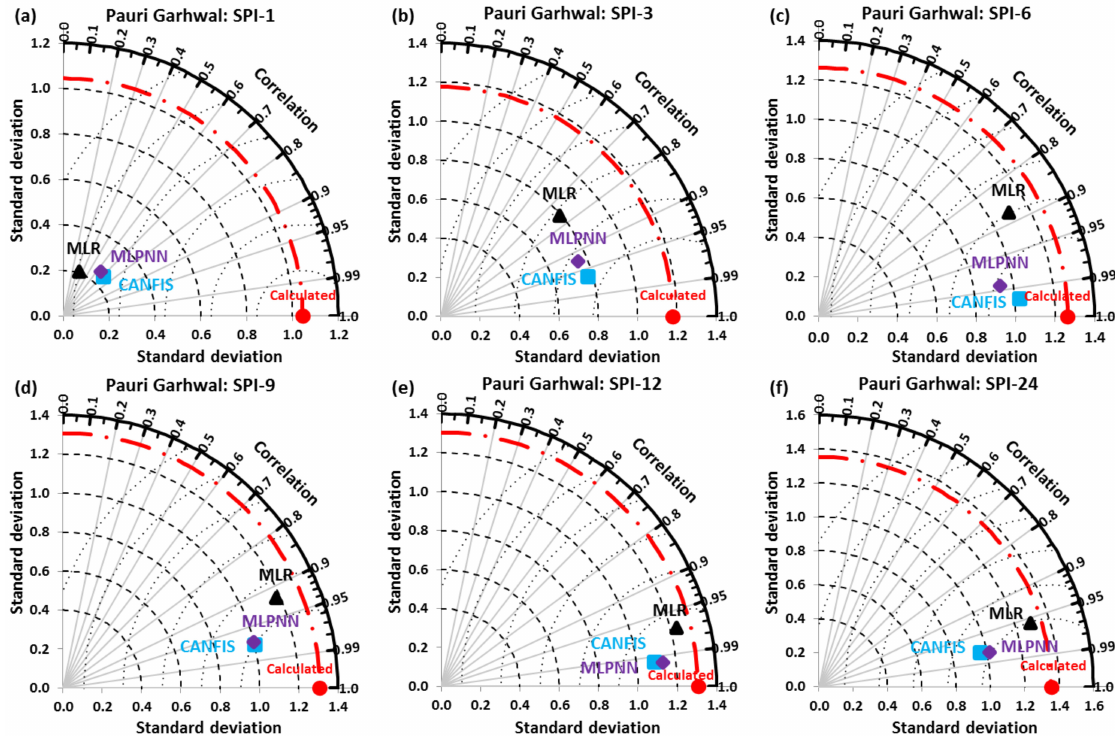
Figure 14. ( a – f ) Taylor diagram of predicted and calculated multi-scalar SPI at Pauri Garhwal